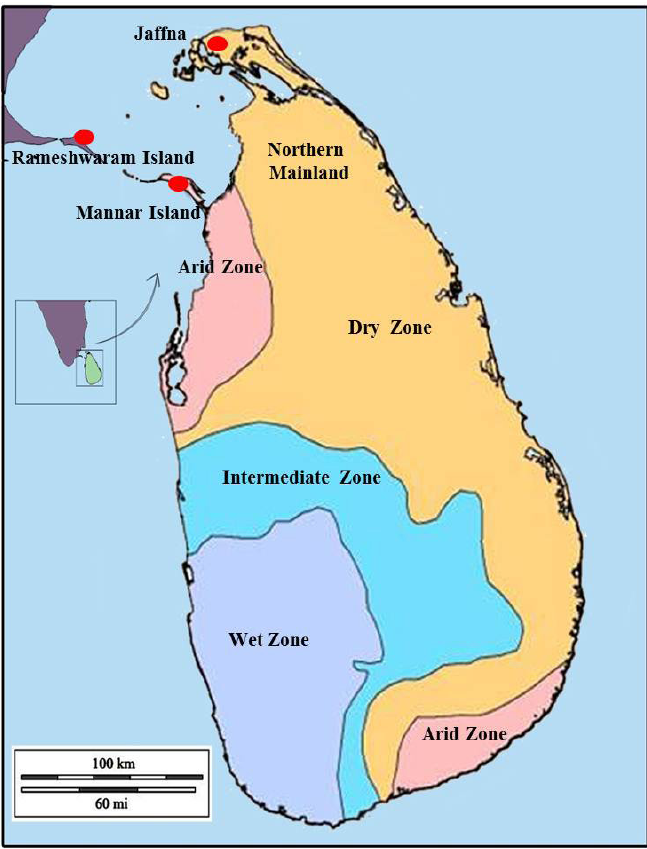
Figure 5: The map of Sri Lanka in the Indian Ocean showing the postulated southward expansion of An. stephensi from Rameshwaram island of South India onto Mannar island and Jaffna city of northern Sri